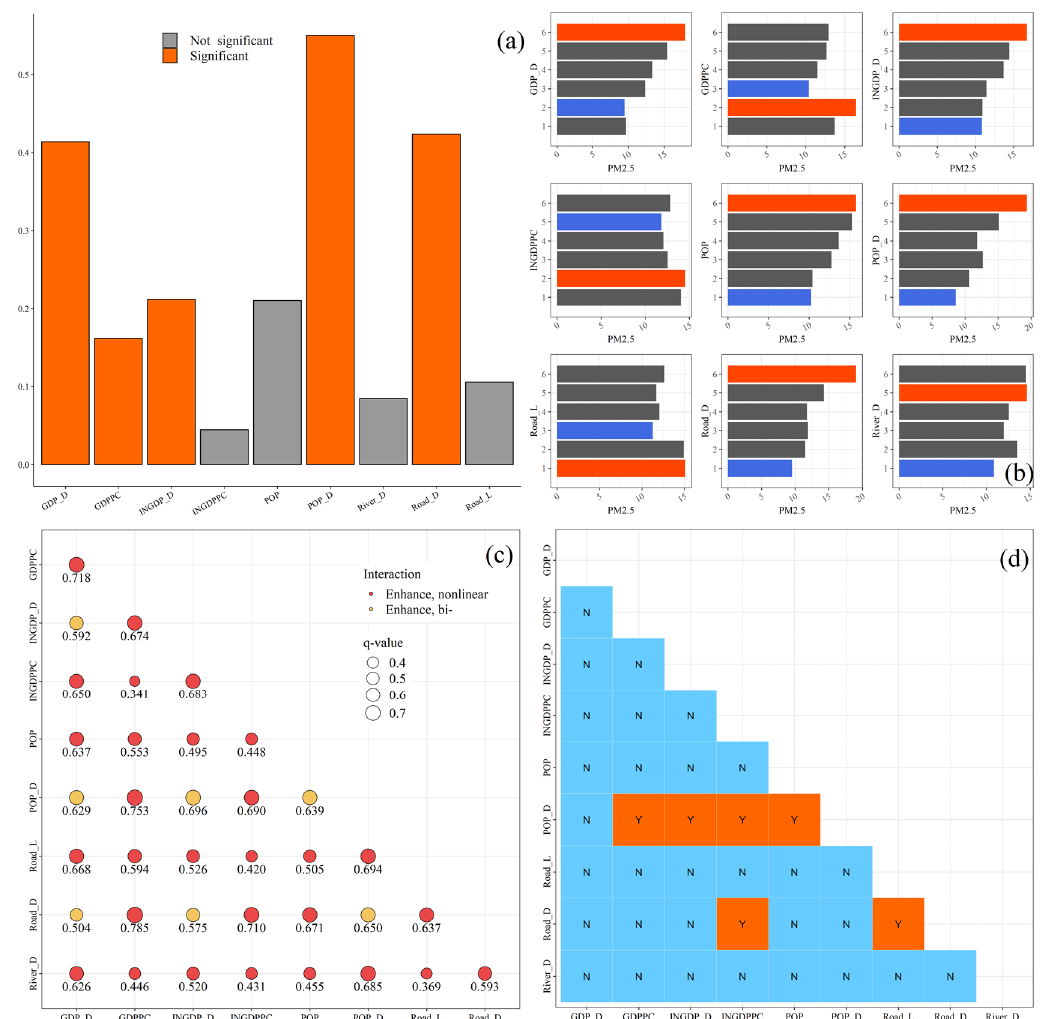
Figure 9. The result of GDM: ( a ) factor detector, ( b ) risk detector, ( c ) interaction detector, ( d ) ecological detector. Note: In Figure 9b, the orange bar means the maximum value in the sub ‐ histogram and the blue bar means the minimum value in the sub ‐ histogram.